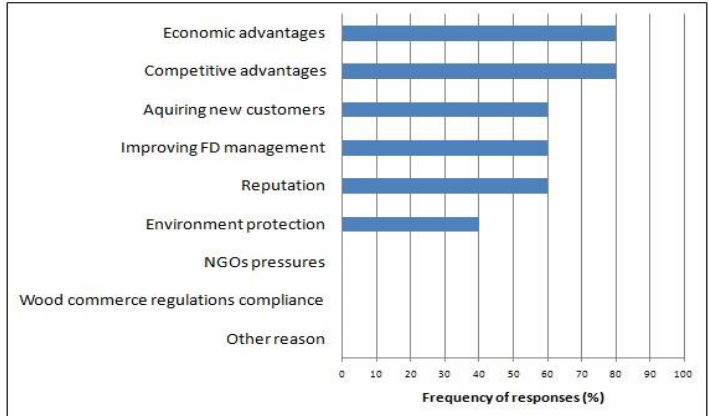
Figure 2. Reasons for adopting FSC certification as indicated by non-state certified FDs managers